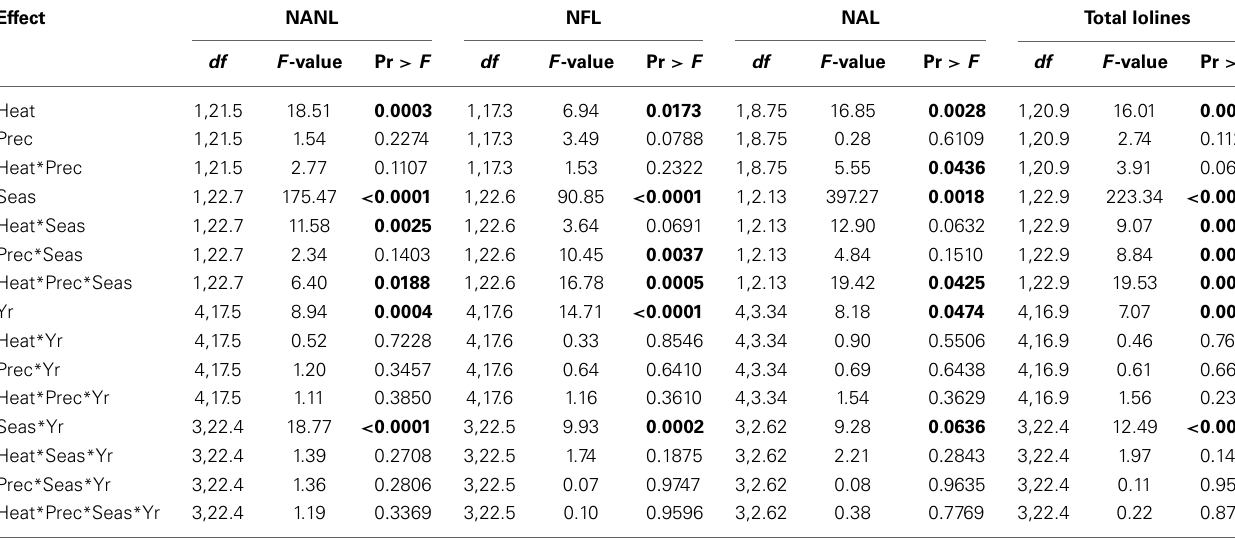
Table 5 | Statistical results of the effects of the climate treatments ( + heat and + precip), season, year, and their interactions on concentrations of N -acetyl norloline (NANL), N -formyl loline (NFL), N -acetyl loline (NAL), and their sum (total lolines measured in this study) in endophyte infected tall fescue